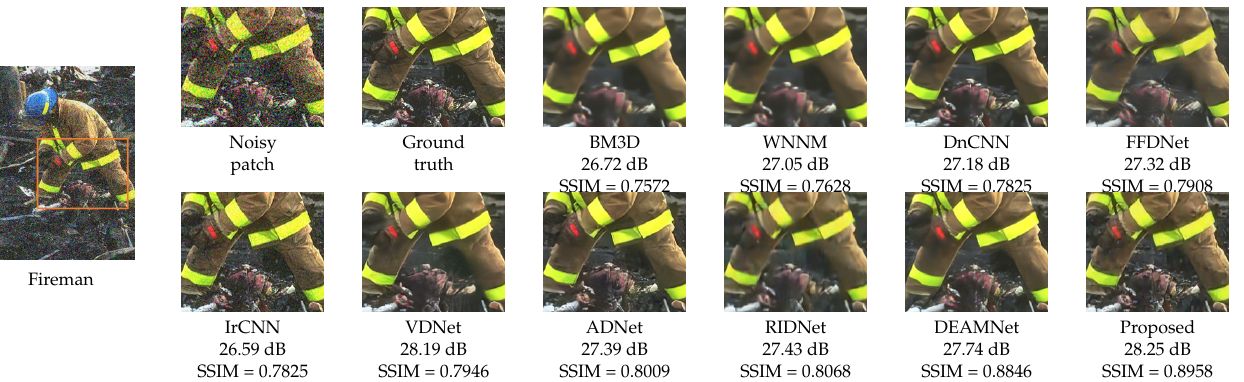
Figure 7. Visual quality comparison with PSNR and SSIM scores for “Fireman” from the BSD68 dataset with AWGN noise level σ = 50 (for best view, zooming in is recommended).